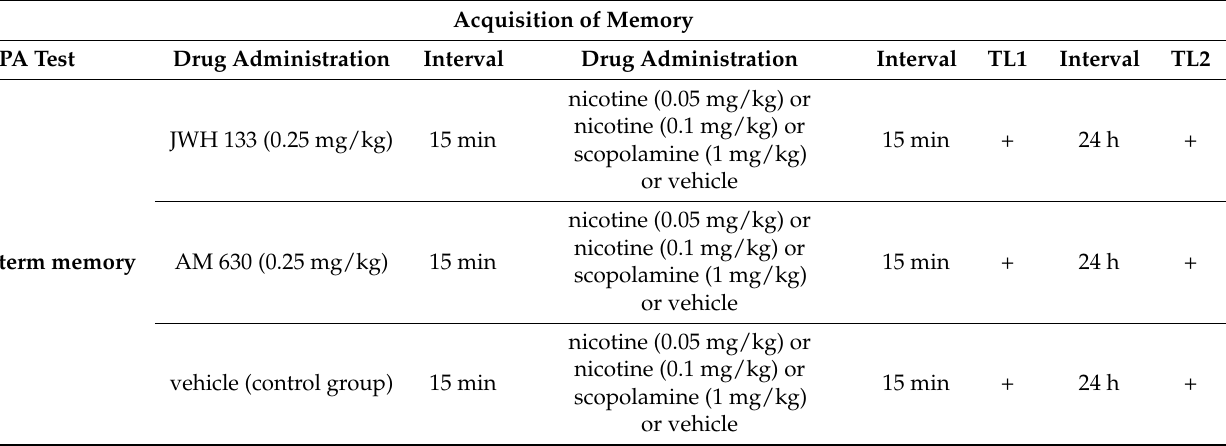
Table 3. The scheme of CB2 and cholinergic receptor ligands co-administration during the assessment of long-term memory acquisition in the PA test in mice.